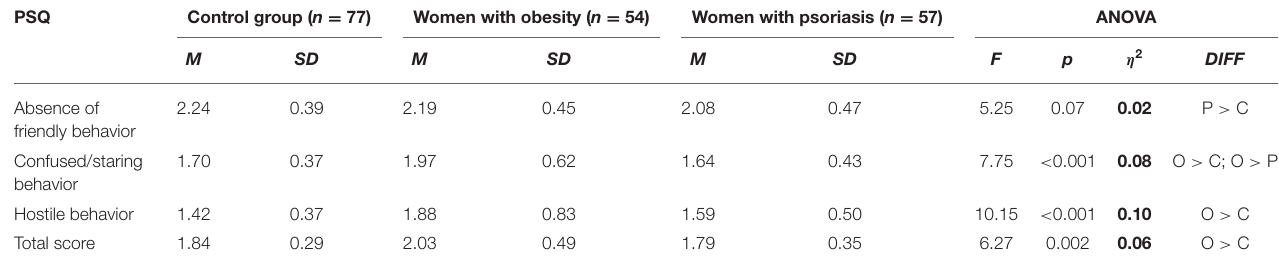
TABLE 3 | Differences in perceived stigma between the groups. PSQ Control group ( n = 77) Women with obesity ( n =